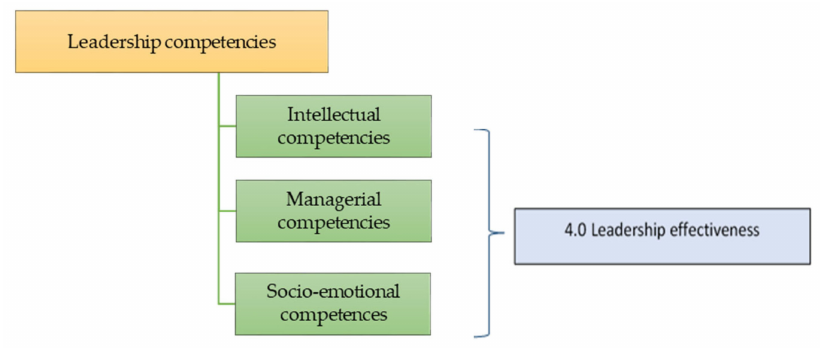
Figure 2. Diagram of the research model based on key structure of leadership competencies. Source: Own